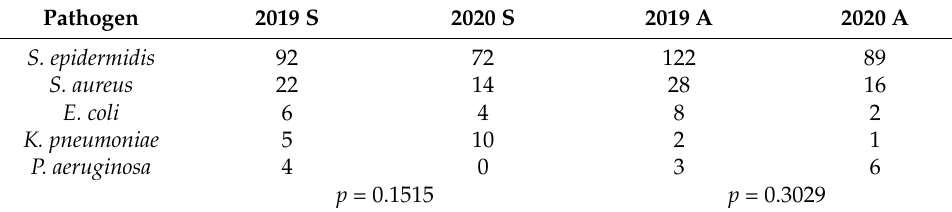
Figure 4. Pathogens found in urine cultures. Table 3. Urine cultures. Period 432 Table 4. Pathogens found in urine cultures. Pathogen